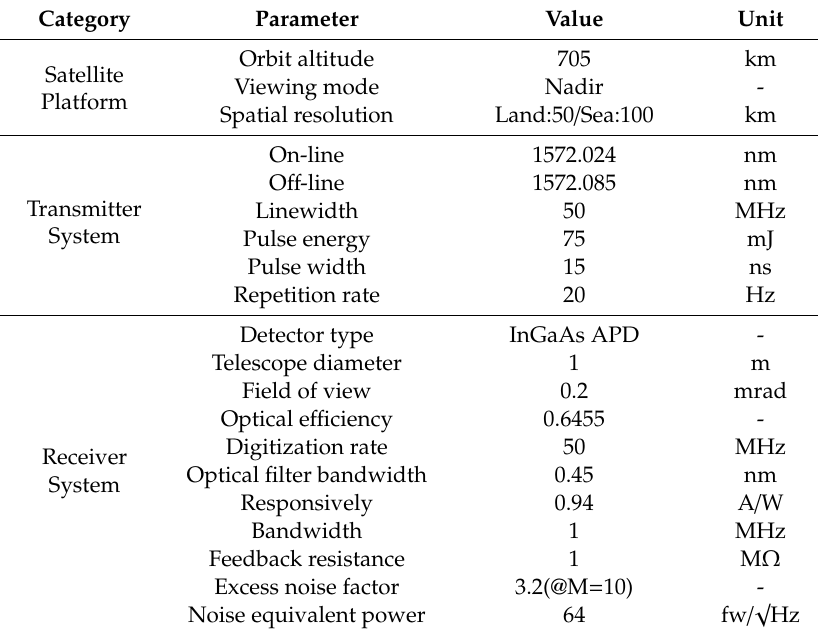
Table 1. Atmospheric Environment Monitoring Satellite (AEMS) platform and hardware parameters of carbon dioxide integrated path di ff erential absorption (AC-IPDA)